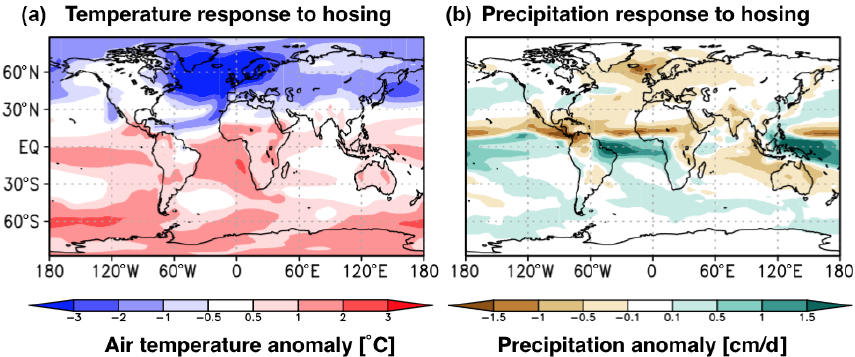
Figure 7. Atmospheric responses to freshwater hosing in MIS3–5aiceH. (a) Annual mean surface air temperature ( ◦ C, color) and (b) pre- cipitation anomaly (cmd − 1 , color). Differences between the last 100 years of hosing and last 100 years before hosing are